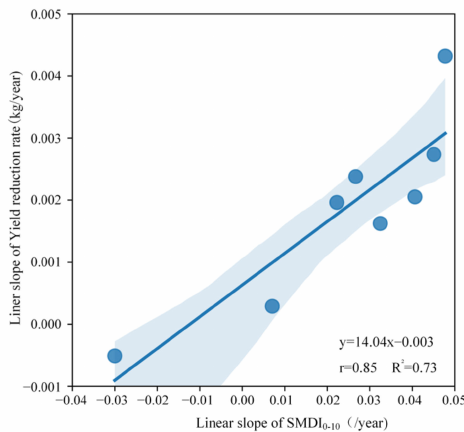
Figure 10. Variations in the linear slopes of spring wheat yield reduction rate vs. the 2-month SMDI 0–10 in May. (The shaded area represents 95 confidence